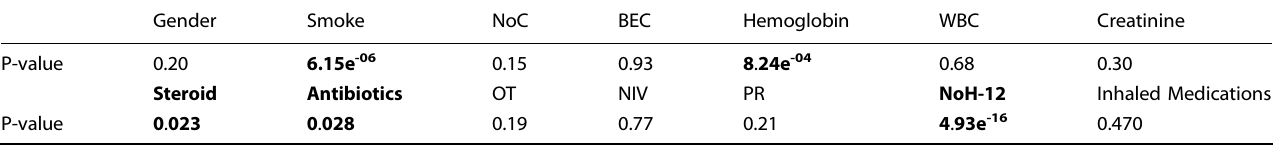
Table 4. Results of Chi-Square test for categorical variable.